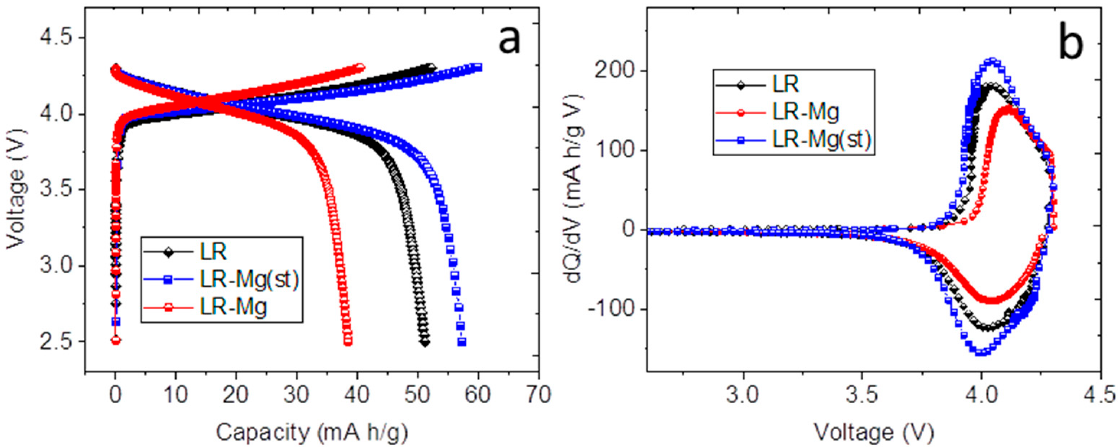
Figure 4. ( a ) The charge ‐ discharge curves and ( b ) the corresponding differential capacity (dQ/dV) plots in the second cycle in the potential range of 2.5–4.3 V. Sample names are shown in the figures.